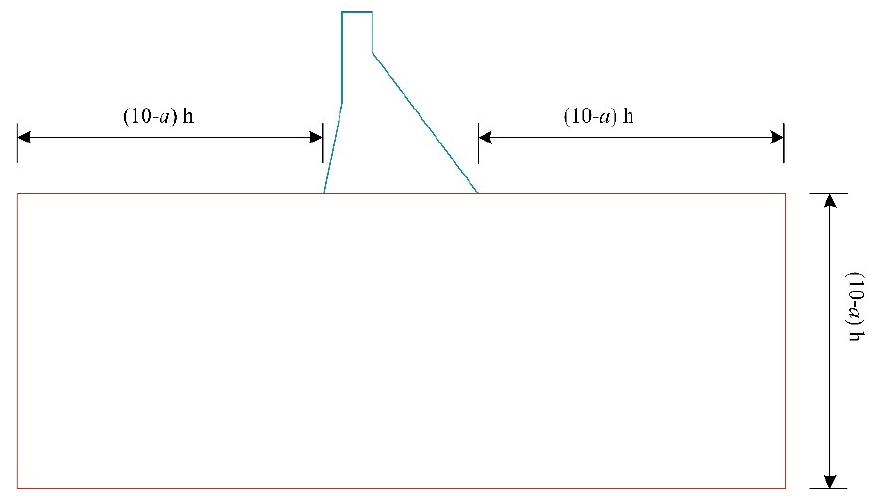
Figure 3. The calculation diagram of the foundation range selection.